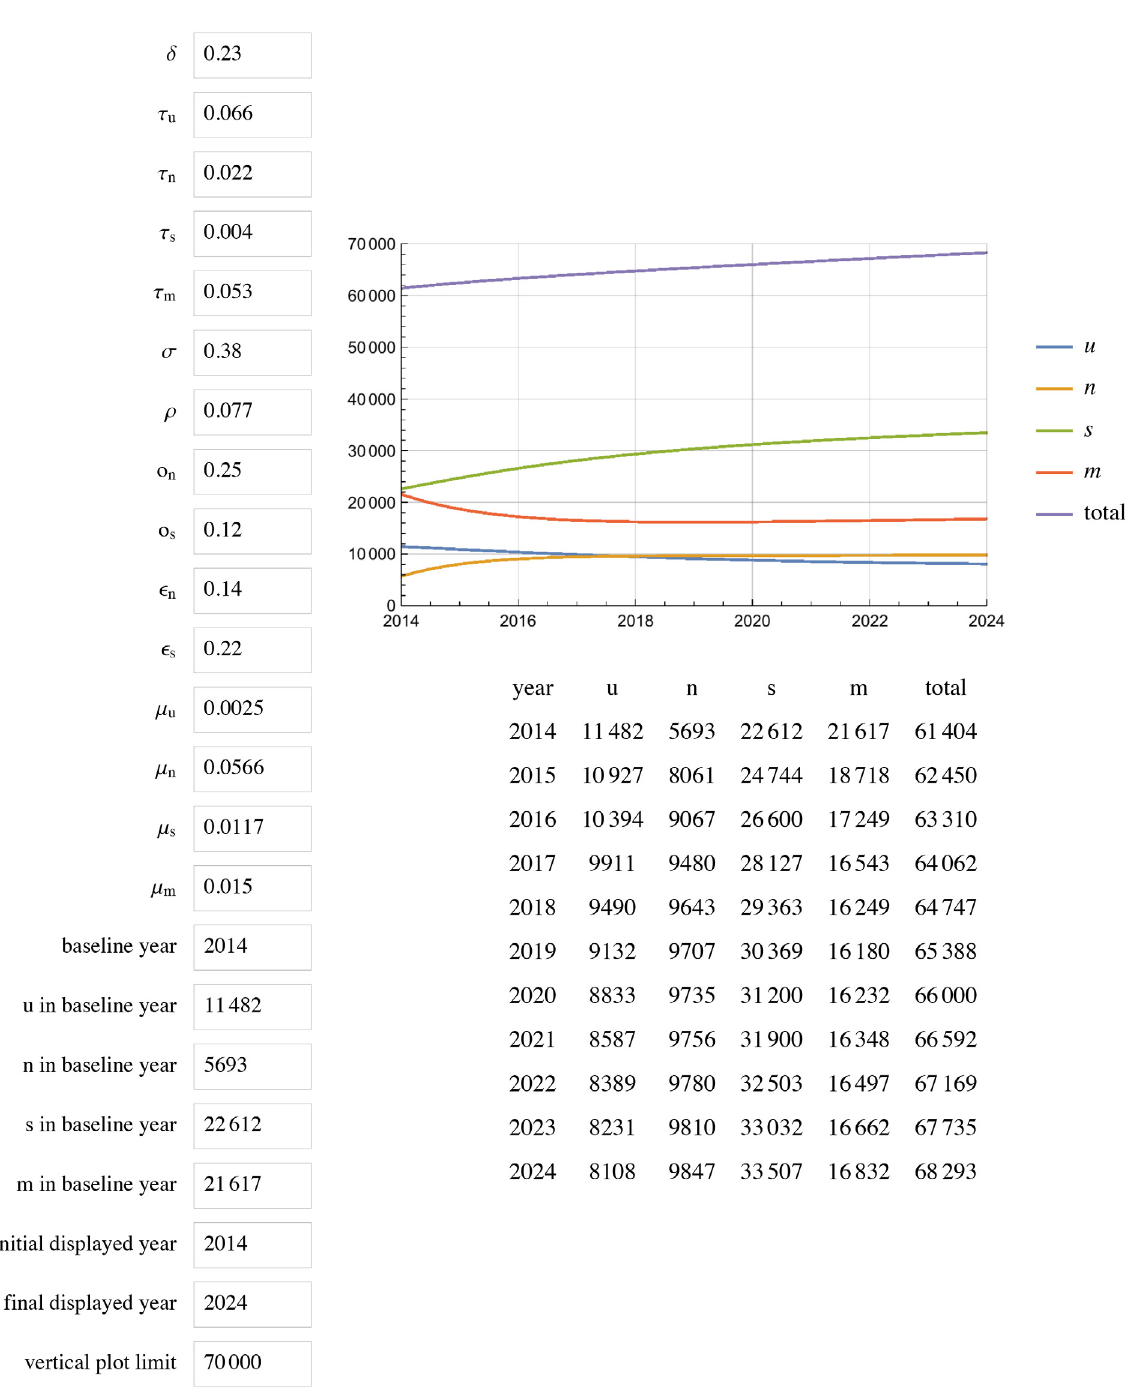
Fig 3. HIV prevalence projections with rates of (cid:2) n and (cid:2) s doubled. (cid:2) n represents the rate of re-entry in care but not VS. (cid:2) s represents the rate of r e-entry into care and achieving VS.